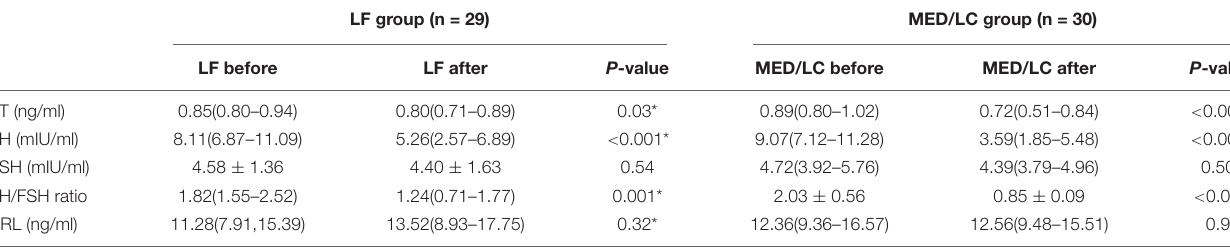
TABLE 4 | Serum sex hormone levels at baseline and after the intervention.